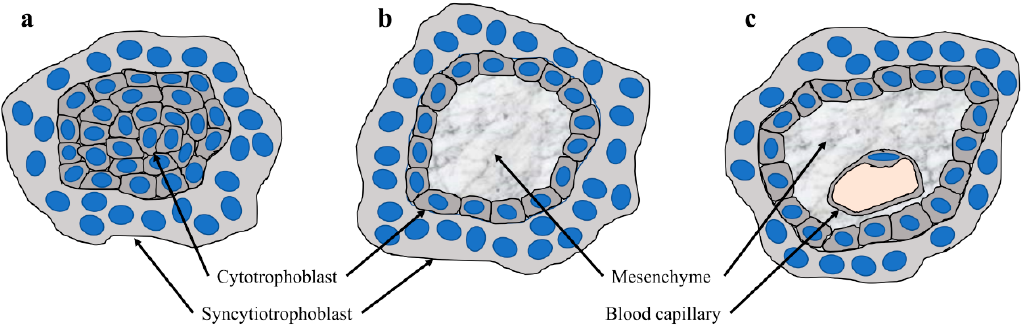
Figure 1. Development of placental villi ( a ) Section through a primary villus which shows a core of cytotrophoblasts covered by the syncytiotrophoblast; ( b ) section through a secondary villus, which shows a core of mesenchyme covered by a two-layered trophoblast epithelium, consisting of an inner, mononucleated cytotrophoblast layer, and the outer syncytiotrophoblast; and ( c ) section through a tertiary villus which shows blood capillaries in the mesenchyme.